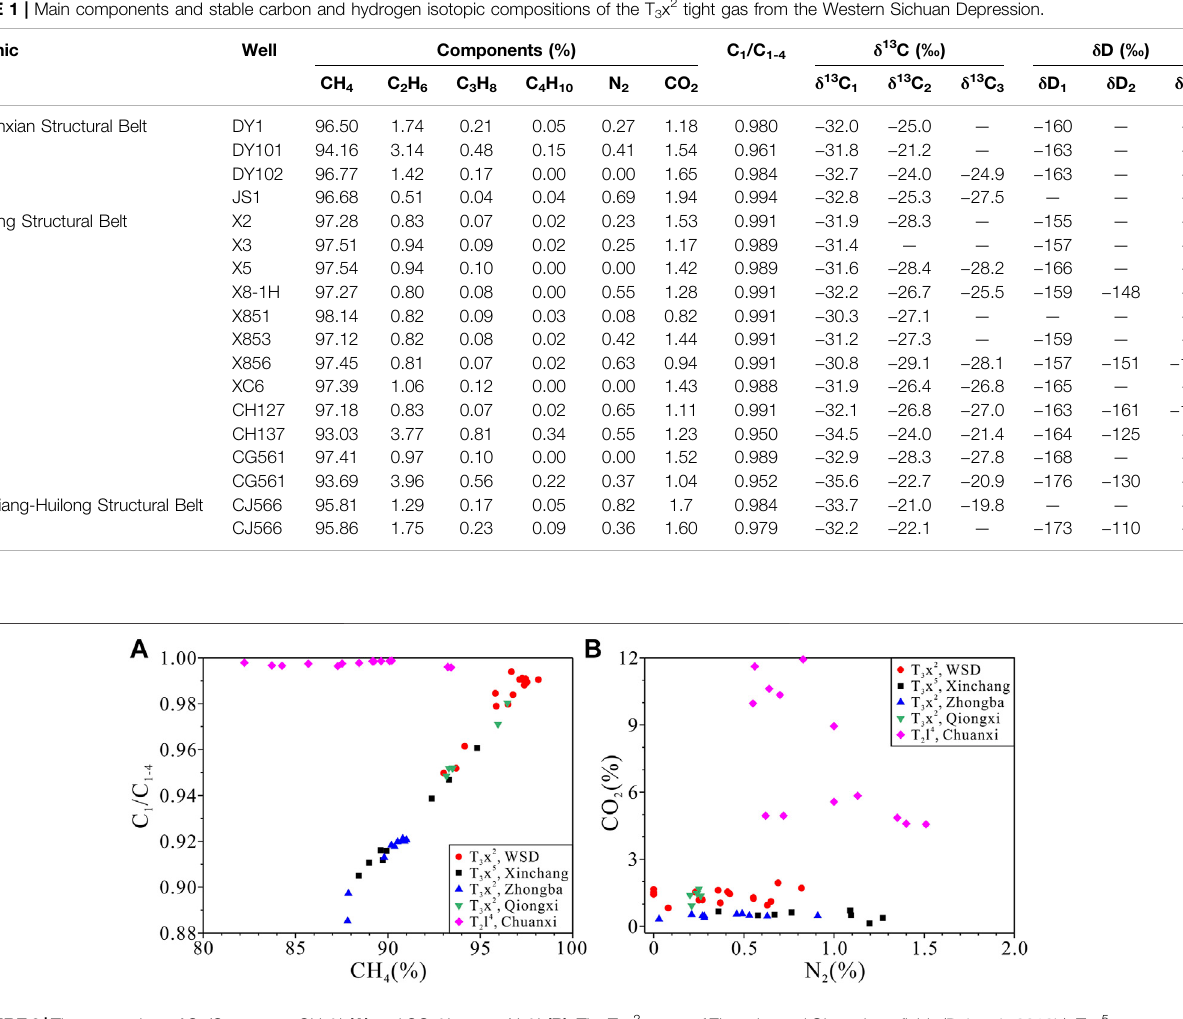
Frontiers in Earth Science |